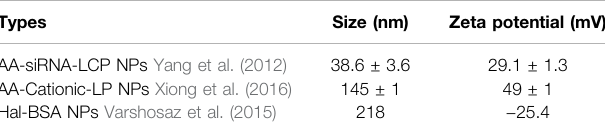
TABLE 6 | σ Receptor antibody for active targeting of nanoparticle drug delivery